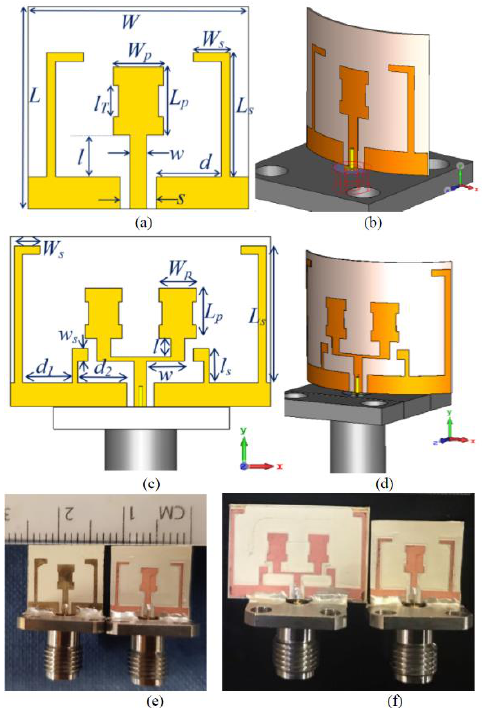
Figure 11. Mm-wave antenna and array fabricated with laser-milling and inkjet printing on LCP substrate. ( a ) Antenna model. ( b ) Conformal antenna model. ( c ) Antenna array model. ( d ) Conformal antenna array model. ( e ) Laser-etched (right) and inkjet-printed (left) fabricated prototype. ( f ) Fabricated antenna (right) and two-element array (left) [96].